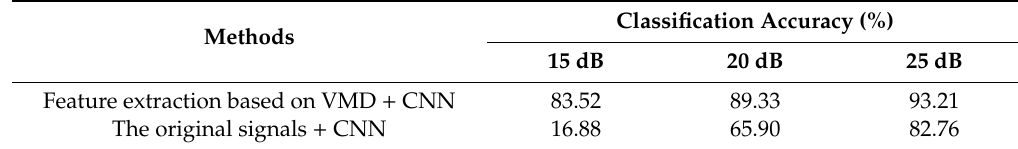
Table 4. Classification accuracy under Gaussian white noise.